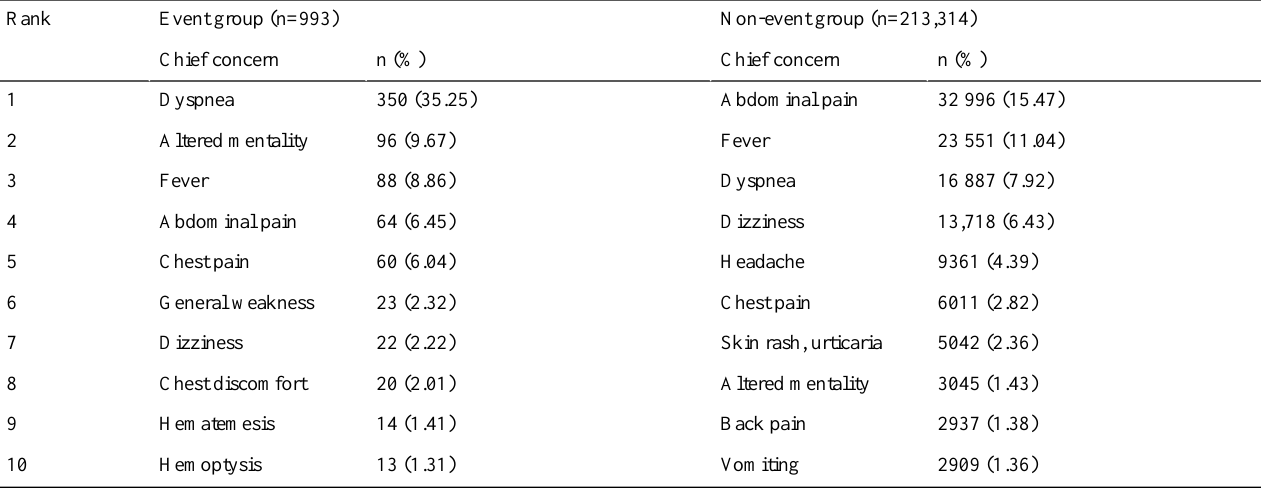
Table 2. Top 10 chief concerns in the event and non-event